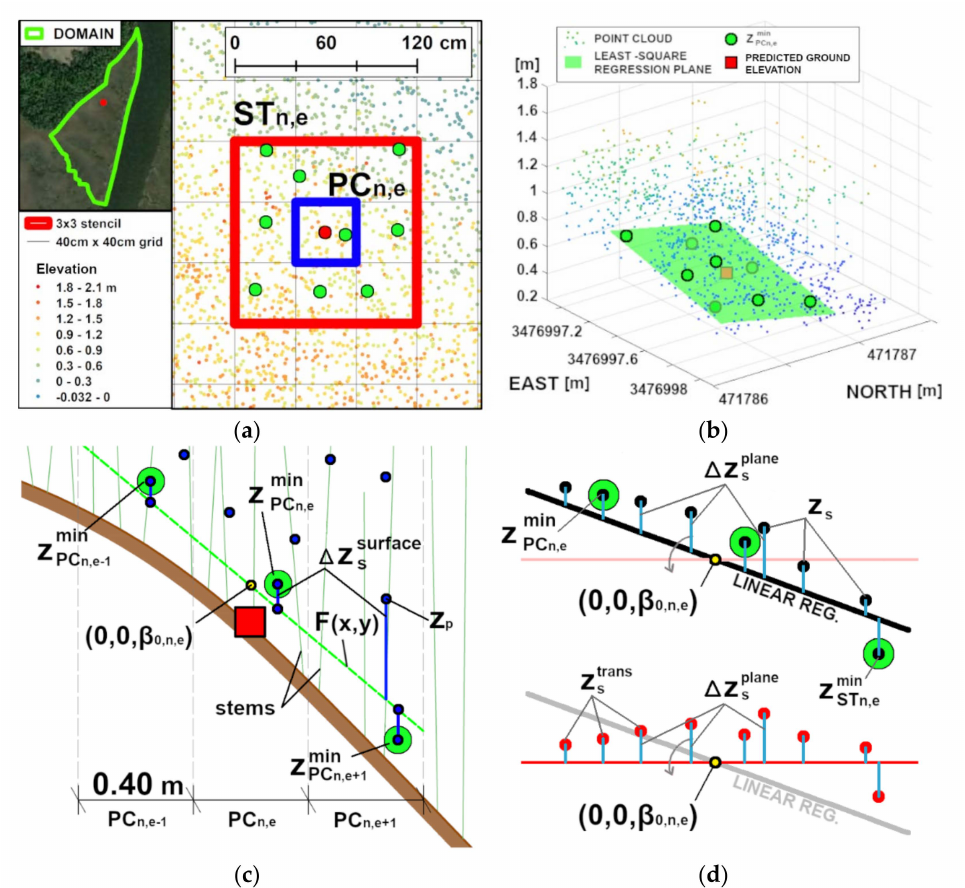
Figure A1. The image reports the steps of the procedure used to transform the point cloud and calculate the ground elevation on a specific cell ( n,e ). ( a ) The point cloud is split using a regular grid (STEP 1), and the elevation of the lowest point in each ( n,e ) cell (green dots) is calculated (STEP 2). ( b ) The lowest points (green dots) of the cells belonging to a stencil ( ST n,e ) are used to determine a regression plane (STEP 3). ( c ) The vertical distance ( ∆ z surface s ) between the regression plane and each point ( s ) of the point cloud contained in ST n,e is calculated (STEP 4). ( d ) The point cloud contained in ST n,e is transformed (red points) and the relative elevation ( z trans s ) of the points is calculated, using as reference the elevation of the lowest transformed point in ST n,e (STEP 5). The elevation of the lowest point is used as the best estimate of the ground elevation in the central cell of the stencil (STEP 6). STEPs 4–6 are reported in 2D, for clarity. (Adapted from Pinton et al.